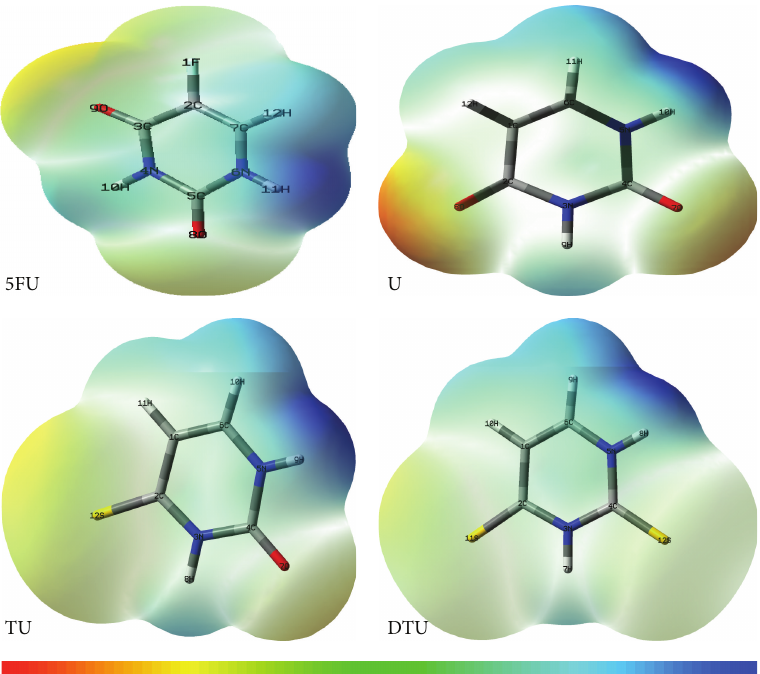
Figure 4: ESP map of simple uraciles. Isovalue = 0.0004; ESP value ranges between − 175kJmol −1 (red) and +279 kJmol −1 (blue).